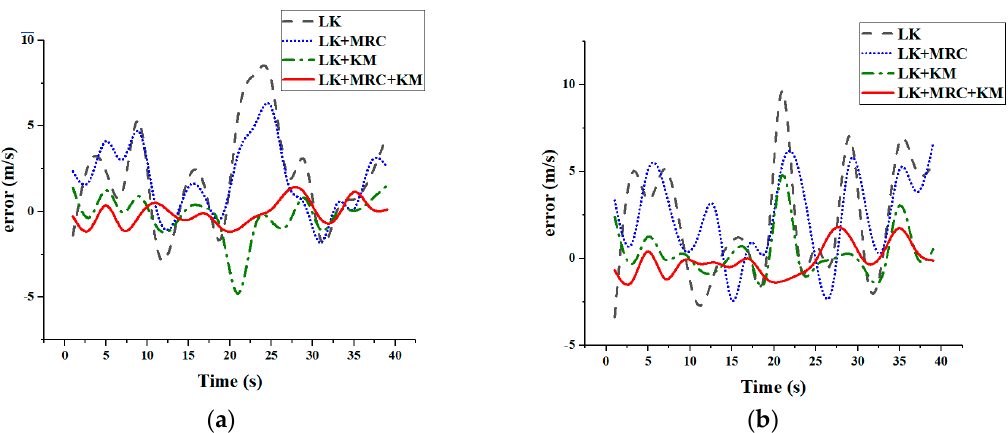
Figure 13. ( a ) Velocity error in X direction of experiment 3; ( b ) velocity error in Y direction of experiment 3. experiment Table 7. Velocity errors of four algorithms in the X direction.